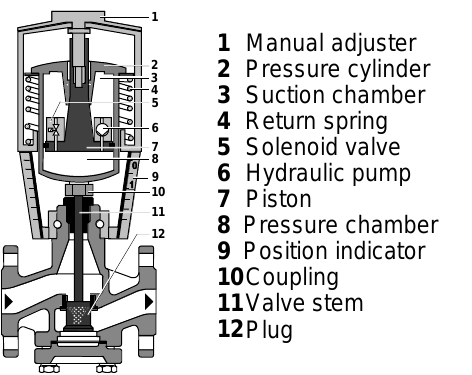
Figure 1. Diagram of the control valve in the steam turbine. Due to frequent opening and closing of the valve in the process of daily operation, the valve stem and valve body are easy to wear, resulting in the stiction, such as valve dead zone. The dead zone is an insensitive area where the valve position does not change with the command. The control valve dead zone can easily cause system